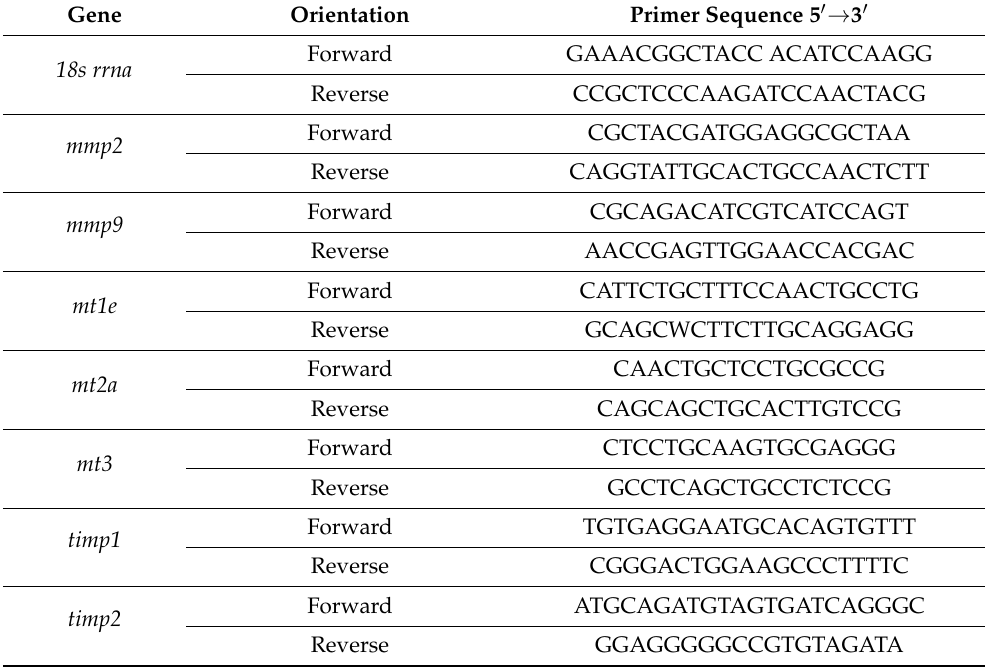
Table 1. Specific primer sequences designed for RT-qPCR